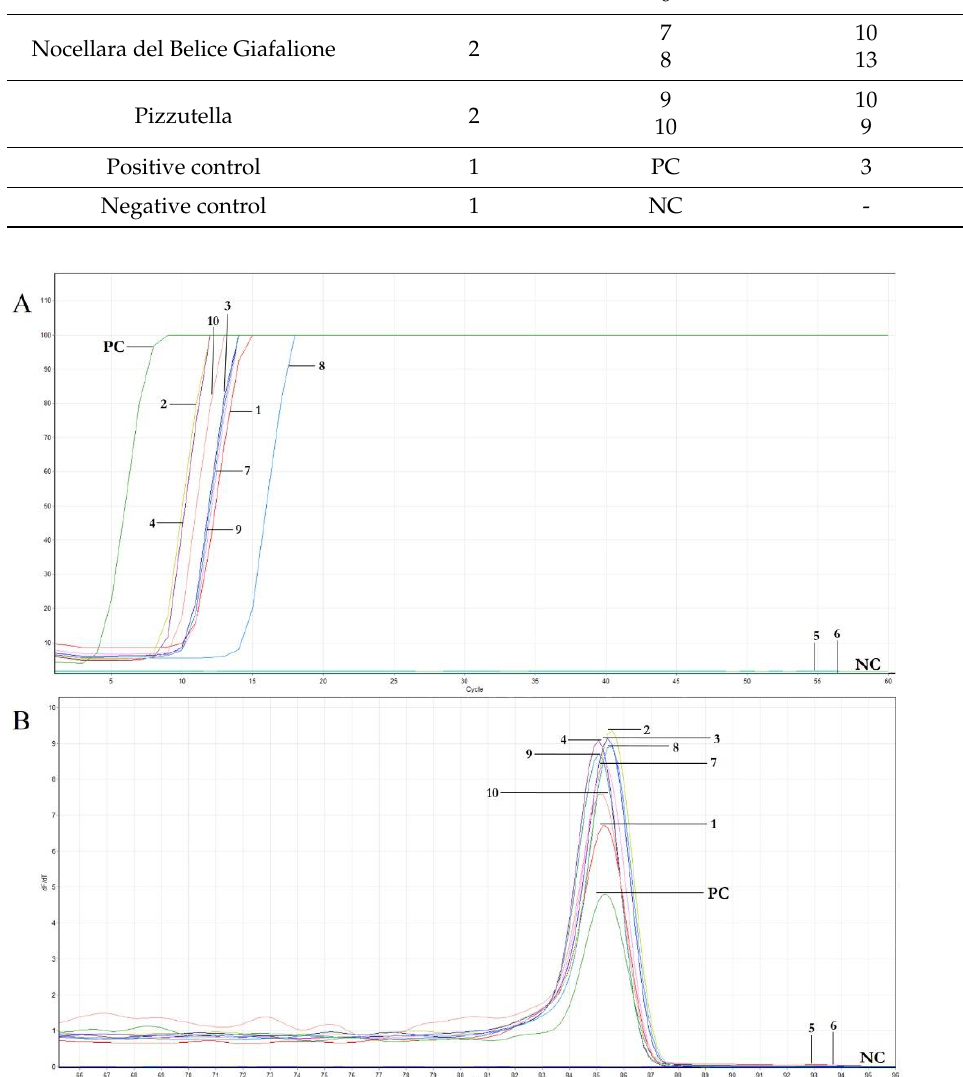
Figure 2. Results of the real time LAMP assay for the detection of OEGV. ( A ): Amplification curves of real-time LAMP assay; ( B ): Melting curves of the amplification curves previously obtained, including positive (PC) and negative control